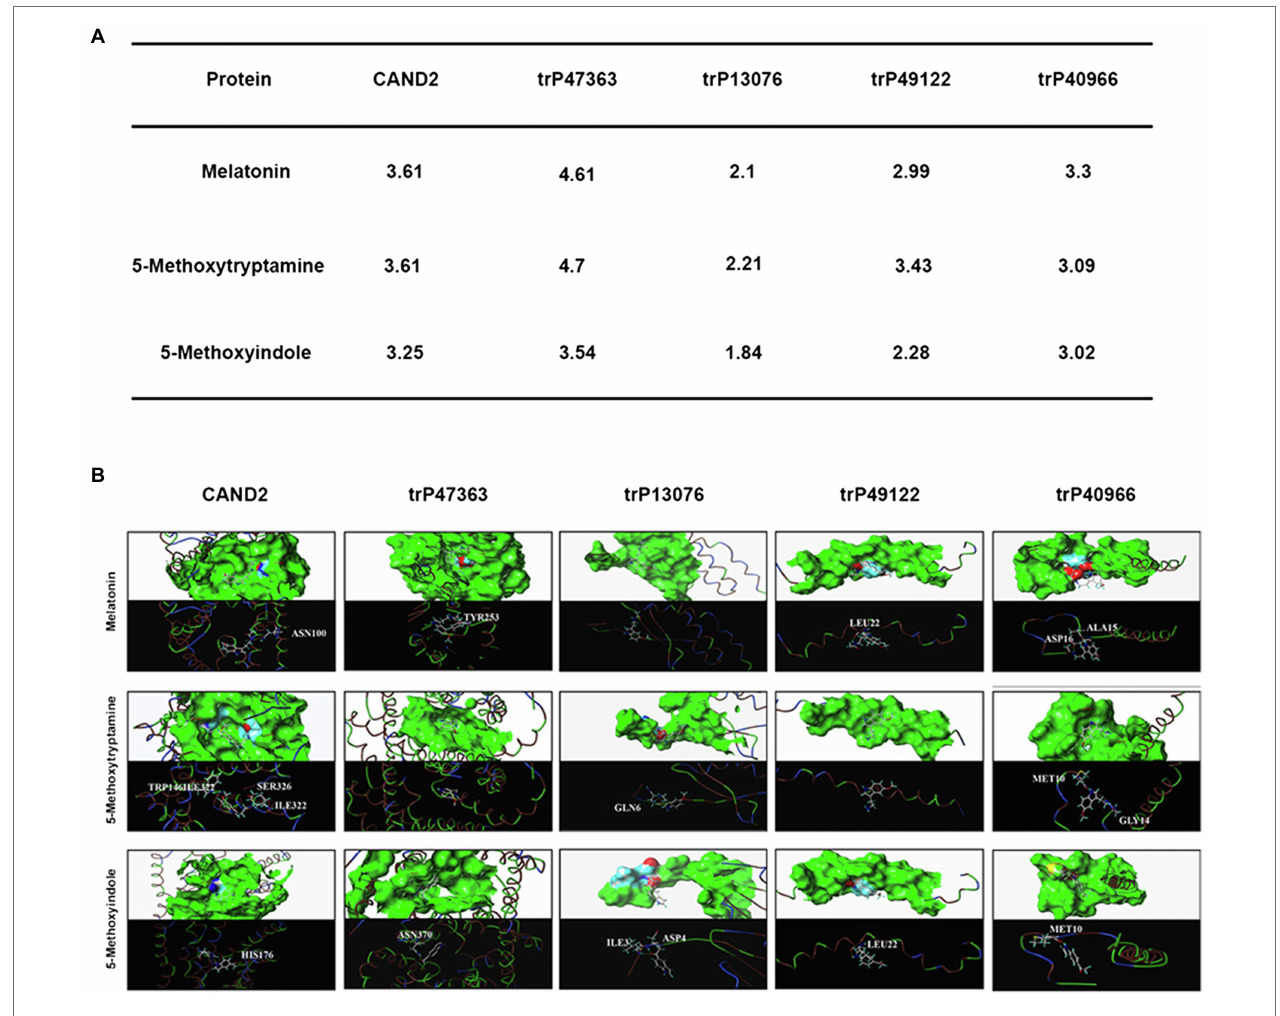
FIGURE 7 | In silico molecular docking analysis of the N. benthamiana membrane receptors and melatonin and 5-methoxyindole. Interaction of N. benthamiana membrane receptors and CAND2 from Arabidopsis with MT and 5-methoxytryptamin and 5-methoxyindole (A) . Molecular docking analysis was conducted using SYBYL software to evaluate the binding model for the active binding pocket of the receptor proteins with MT, 5-methoxytryptamin, and 5-methoxyindole. The receptor proteins are displayed as colored ribbons, with the surface formed by the protein shown in green, and the amino acids capable of binding in blue, white, and red. MT, 5-methoxytryptamin, and 5-methoxyindole are represented as white, dark blue, and wine-red sticks. H-bonding interactions are indicated with dashed yellow lines (B)